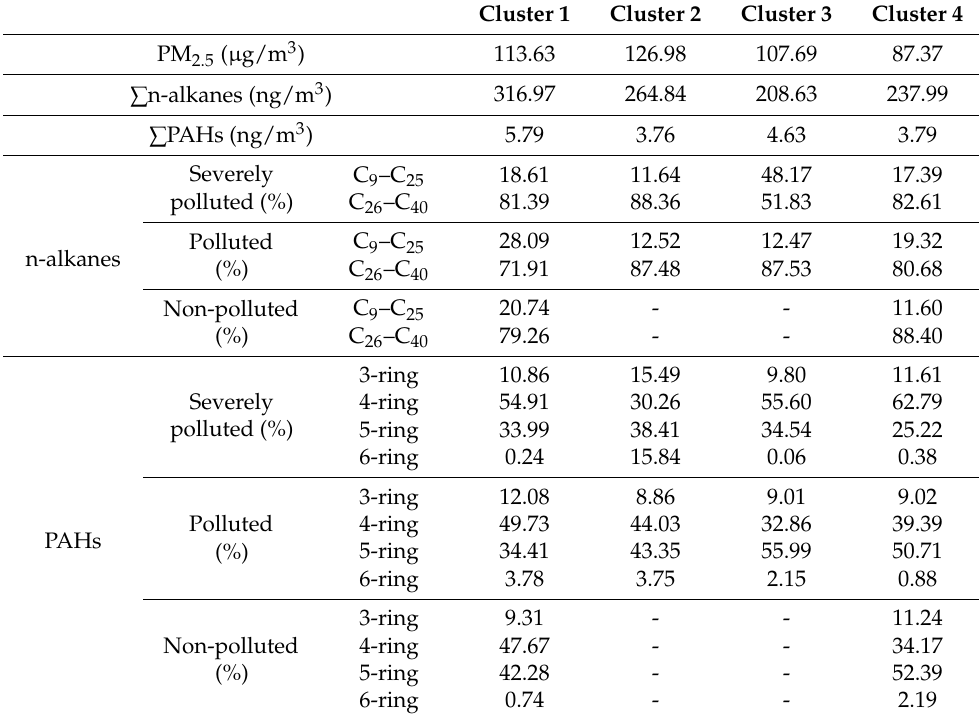
Figure 5. Clusters analysis of backward trajectories in 72 h, 100 m during sampling periods at Changzhou. Table 7. Variation in the percentages of n-alkanes and PAHs under four air masses clusters on different polluted days.